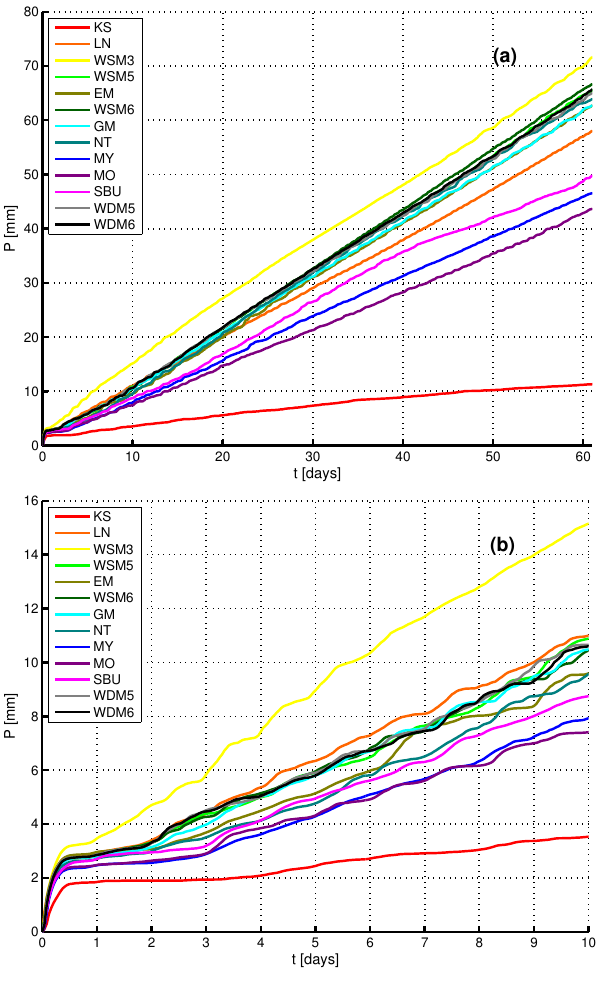
Fig. 6. Comparison of mean accumulated precipitation for the 13 microphysical schemes, in (a) the complete time series and in (b) the zoom over the first 10 days.